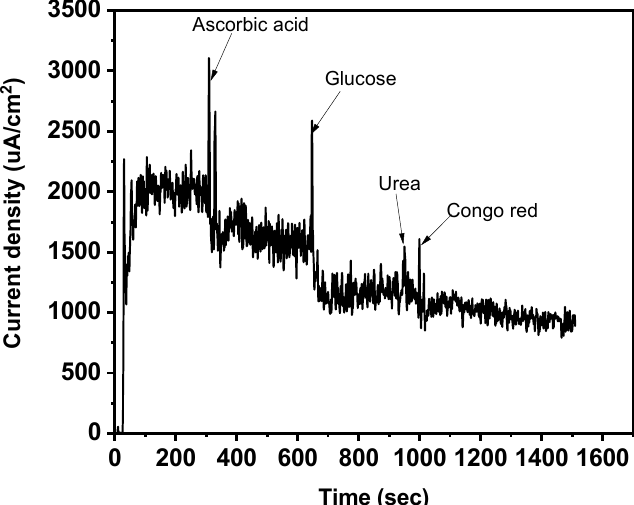
Figure 12. Effect of scan rate on CV and interfering species (potential 1.18 V).